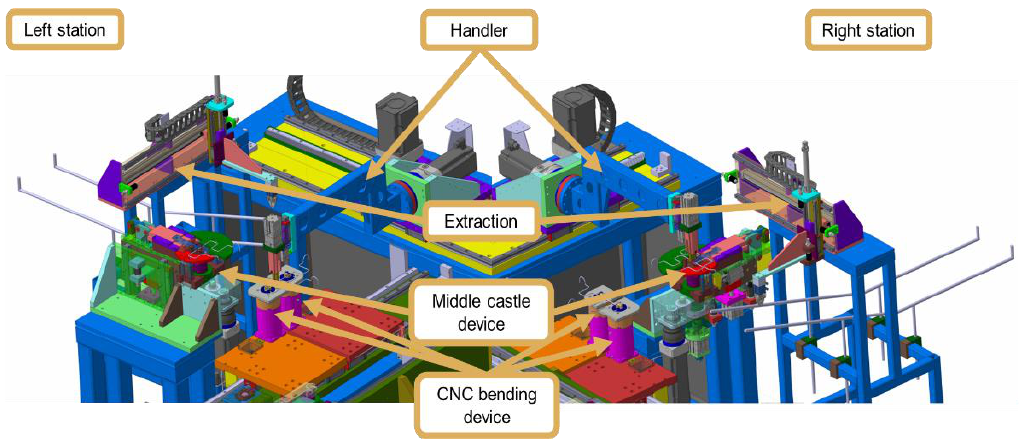
Figure 22. Left and right station. Figure 22.